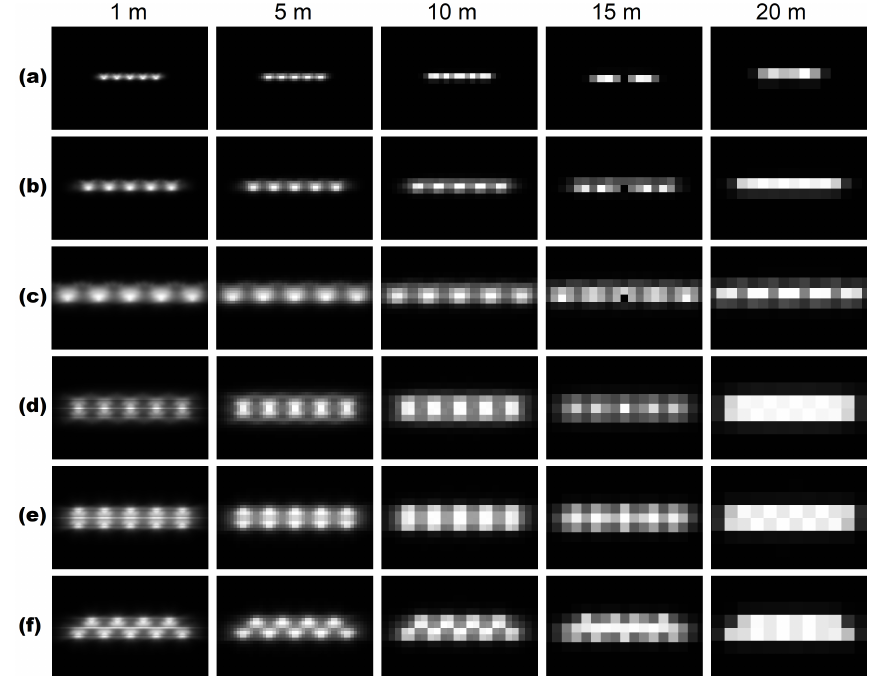
Figure 7. Single-row arrangement of five lamps with different spacing and mounting height at different spatial resolutions, with ( a ) spacing of 25m, height of 6m; ( b ) spacing of 40m, height of 10m; ( c ) spacing of 60m, height of 18m. Road lighting arrangements, spacing of 40m, with ( d ) twin central arrangement; ( e ) two-sided opposite arrangement; ( f ) two-sided staggered arrangement of a dual